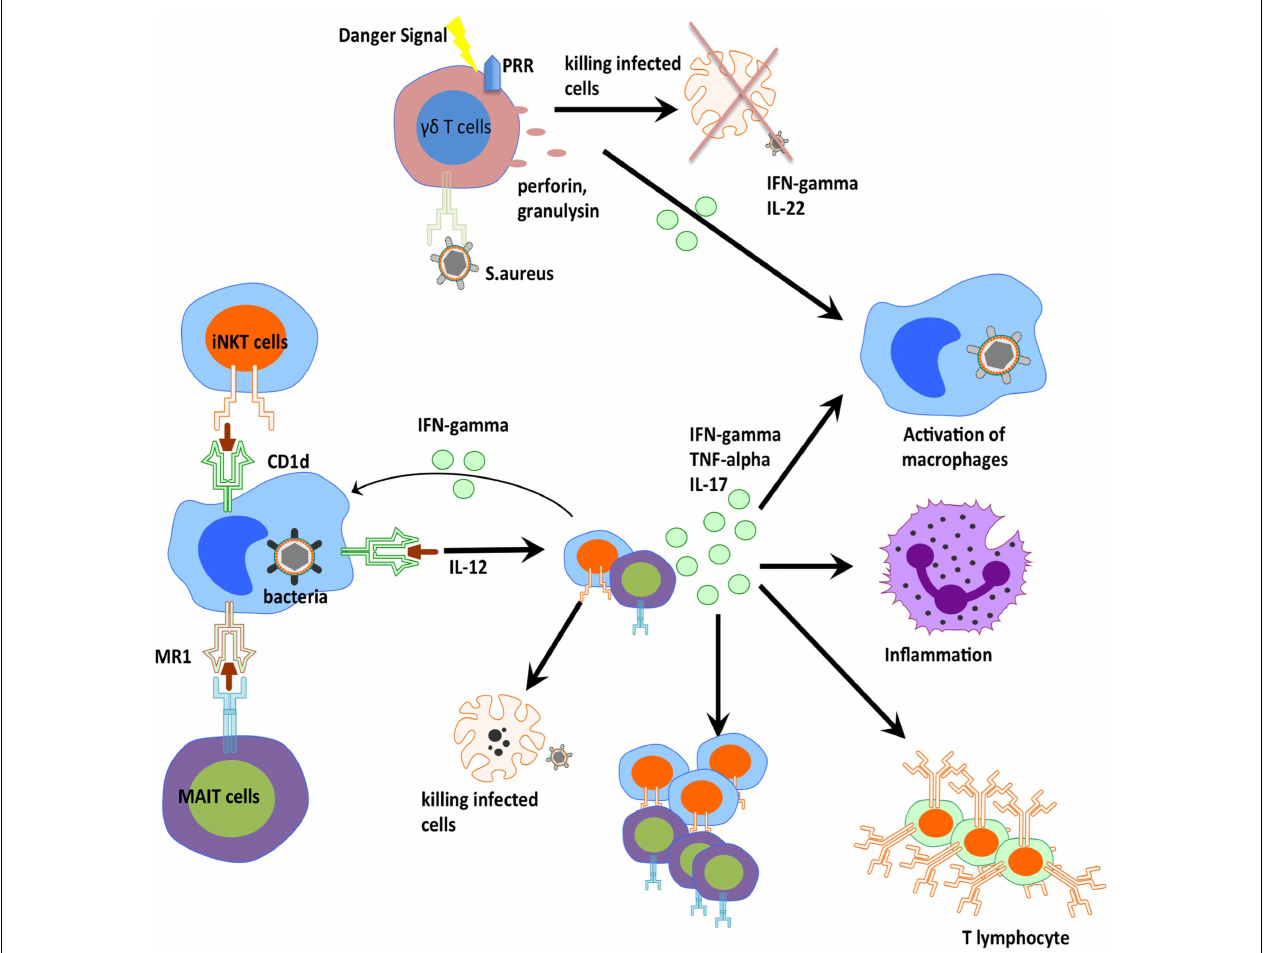
FIGURE 2 | Orchestration of innate T cells in anti-bacterial immunity . iNKT cells, MAIT cells, and gamma delta T cells play an important role in anti-bacterial defense through cytokine production, perforin release, and cross-talk to other innate and adaptive cells.